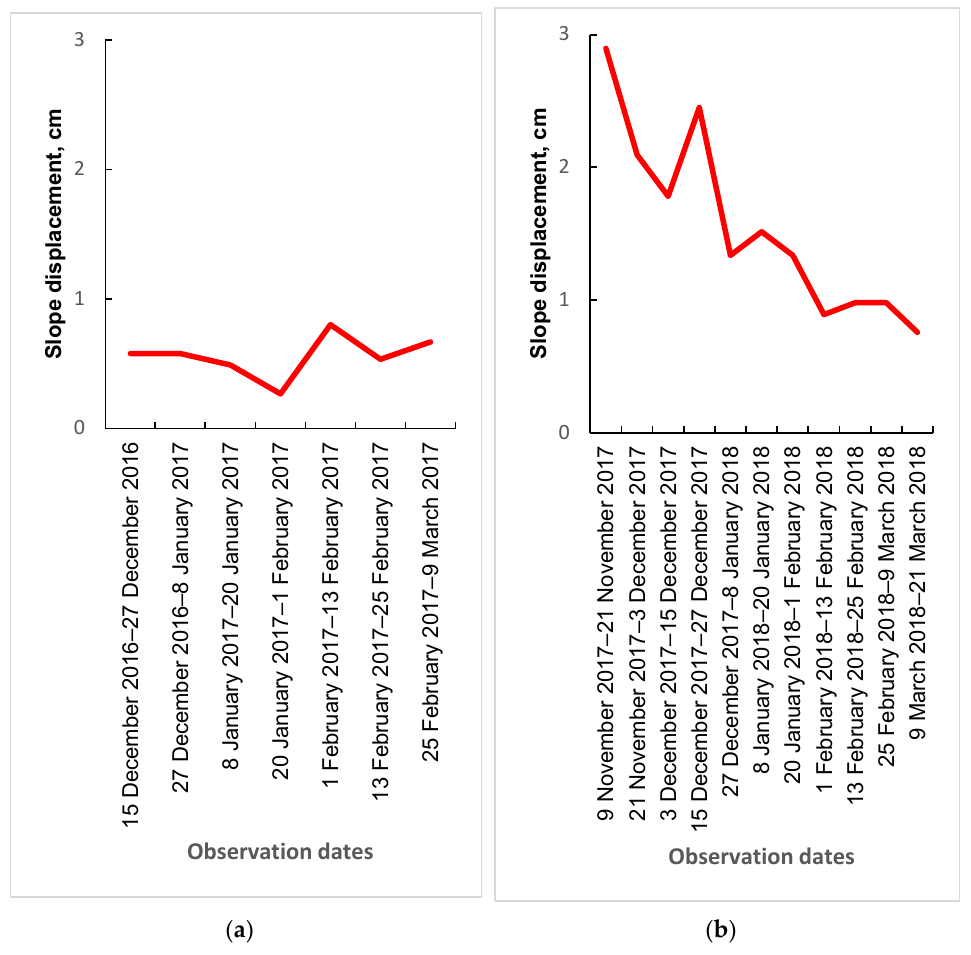
Figure 7. Twelve-day displacements of the landslide surface, cm: ( a ) winter 2016–2017; ( b ) winter 2017–2018.